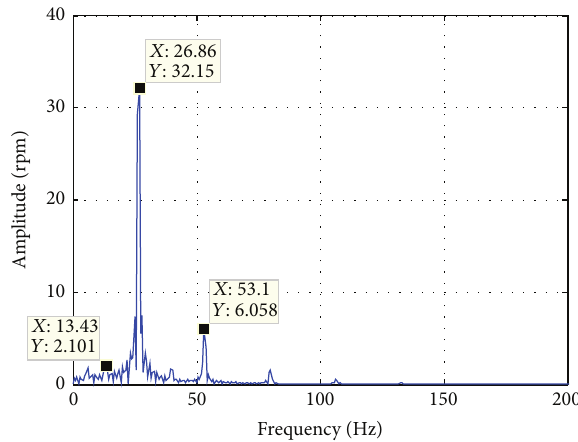
Figure 37: Frequency spectrum of engine